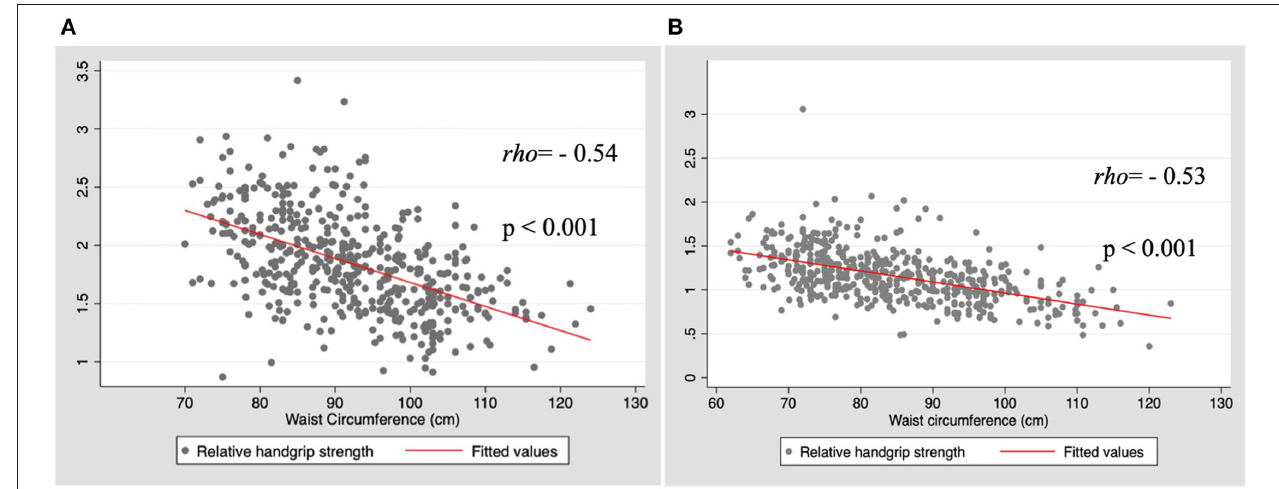
TABLE 3 | Relative handgrip strength (kg/kg/m 2 ) by abdominal obesity status, according to sex and age.